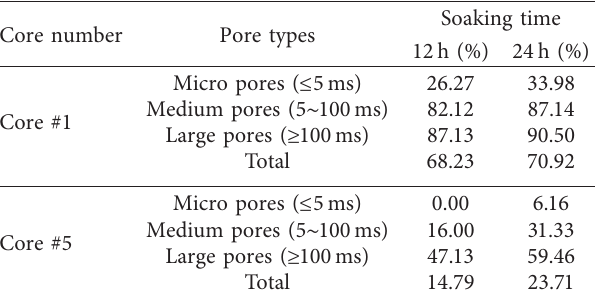
Figure 12: The microscopic remaining oil distribution of matrix core #5 after huff-and-puff tests with different soaking time. Table 4: The oil recovery factor of different pores after huff-and- puff tests with different soaking